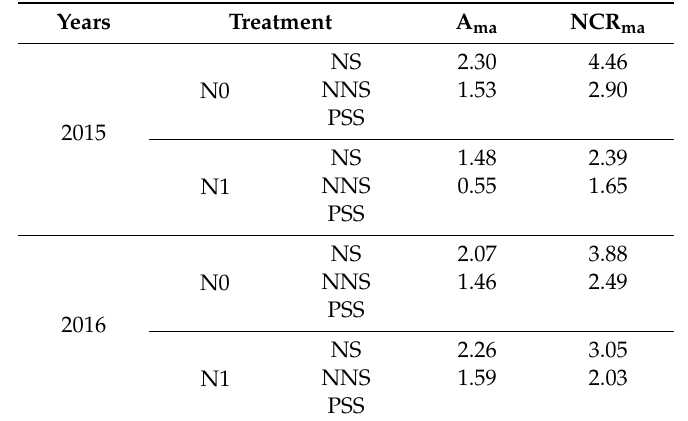
Table A1. Aggressivity and competitiveness of maize relative to alfalfa for the nitrogen level (N) and root separation method (RS) between 2015 and 2016.